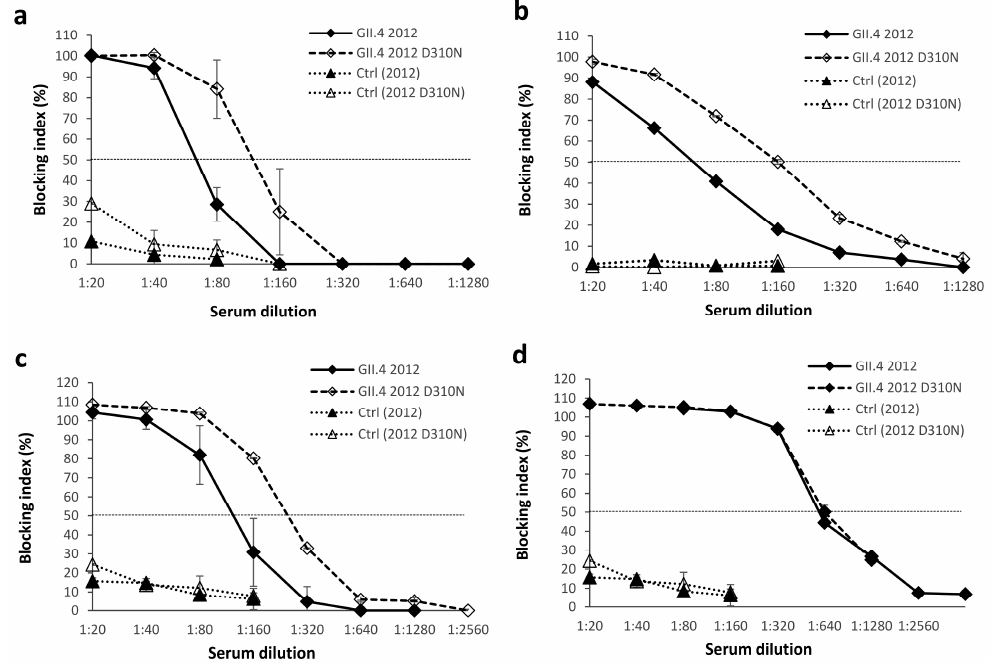
Figure 4. The effect of amino acid (aa) 310 mutation within the NERK motif on cross-blocking activity. Residue 310 of GII.4 2012 virus-like particles (VLPs) was substituted from D (aspartic acid) to N (asparagine) to generate mutated GII.4 2012 D310N VLPs. Pooled GII.4 1999 immune serum was assayed against wild-type and mutated GII.4 2012 VLPs in blocking assays utilizing human saliva type A ( a ), pig gastric mucin ( b ), or synthetic H-type-1 ( c ) as the source of histo-blood group antigens (HBGAs). Pooled GII.4 2012 immune serum was used to block the binding of GII.4 2012 and GII.4 2012 D310N VLPs to synthetic H-type-1 HBGAs ( d ). Control (Ctrl) mice sera illustrate the non-specific blocking activity. The blocking index (percent) was calculated as follows: 100% × ((OD wells with serum/OD wells without serum, maximum binding) × 100%). The symbols represent the mean blocking indexes with standard errors between two repeated assays (( a ) and ( c )) or duplicate wells (( b ) and ( d )) and the horizontal dashed line represents the blocking titer 50%